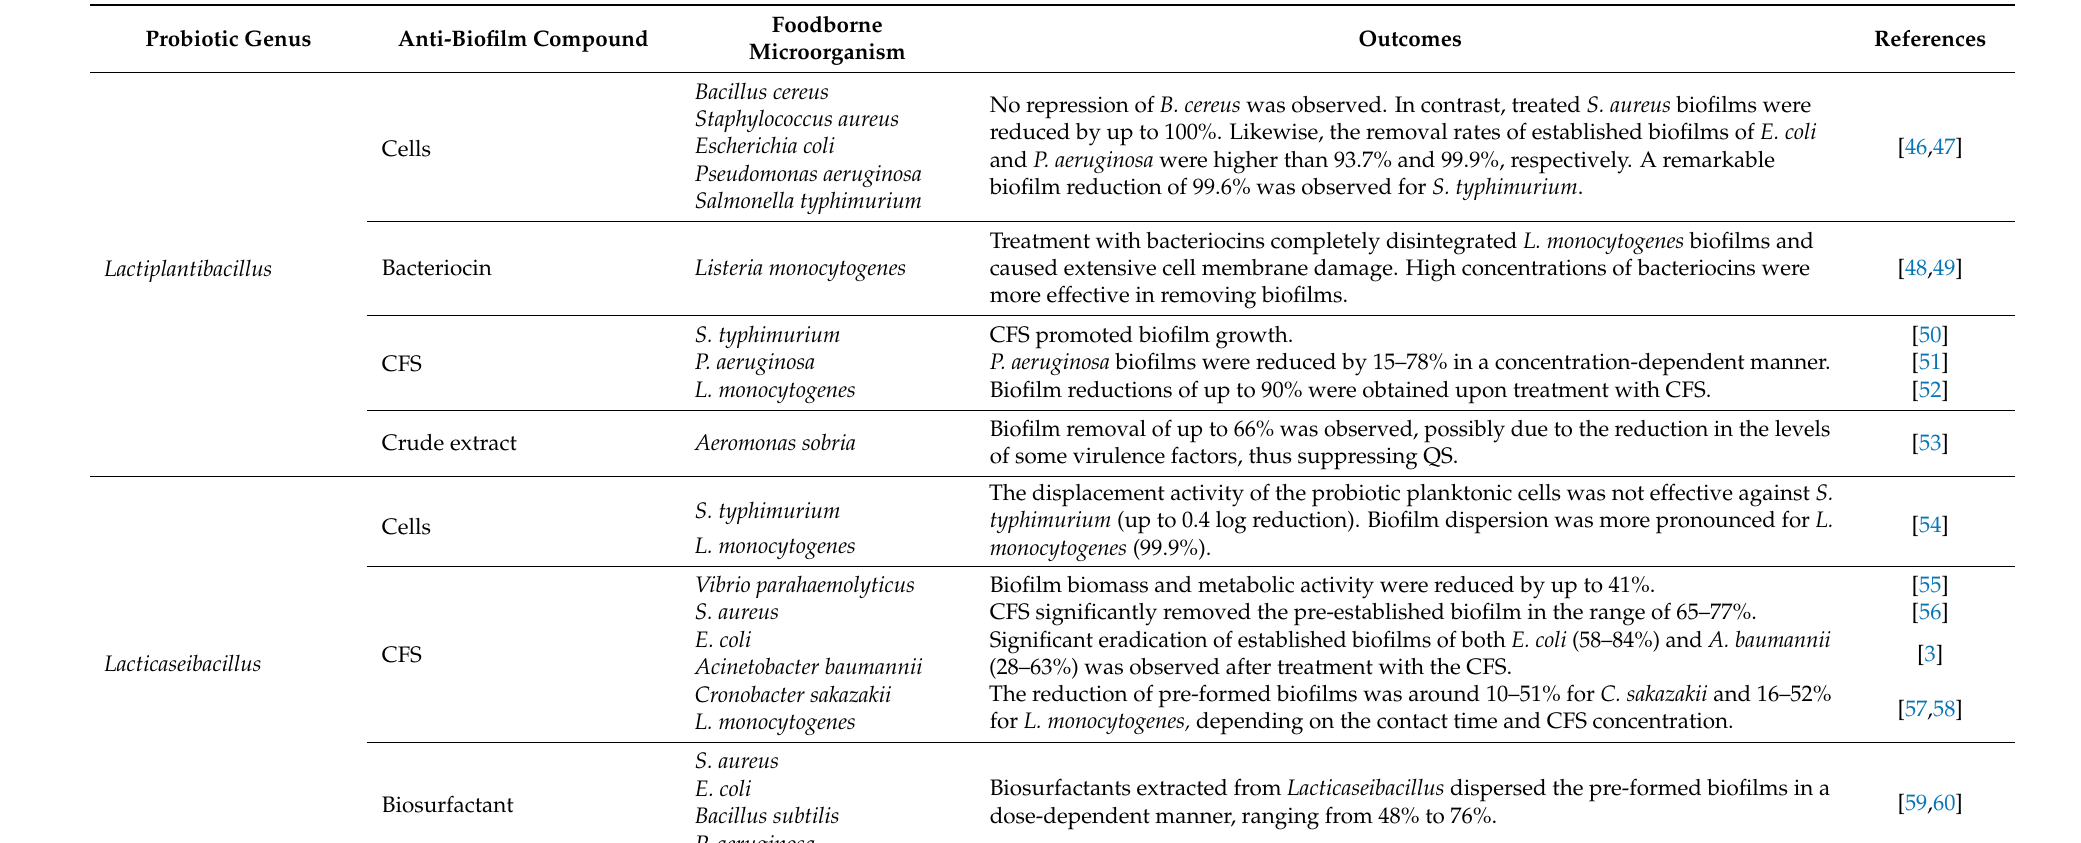
Table 1. Ability of probiotics and/or their metabolites to control biofilms formed in food context through the displacement